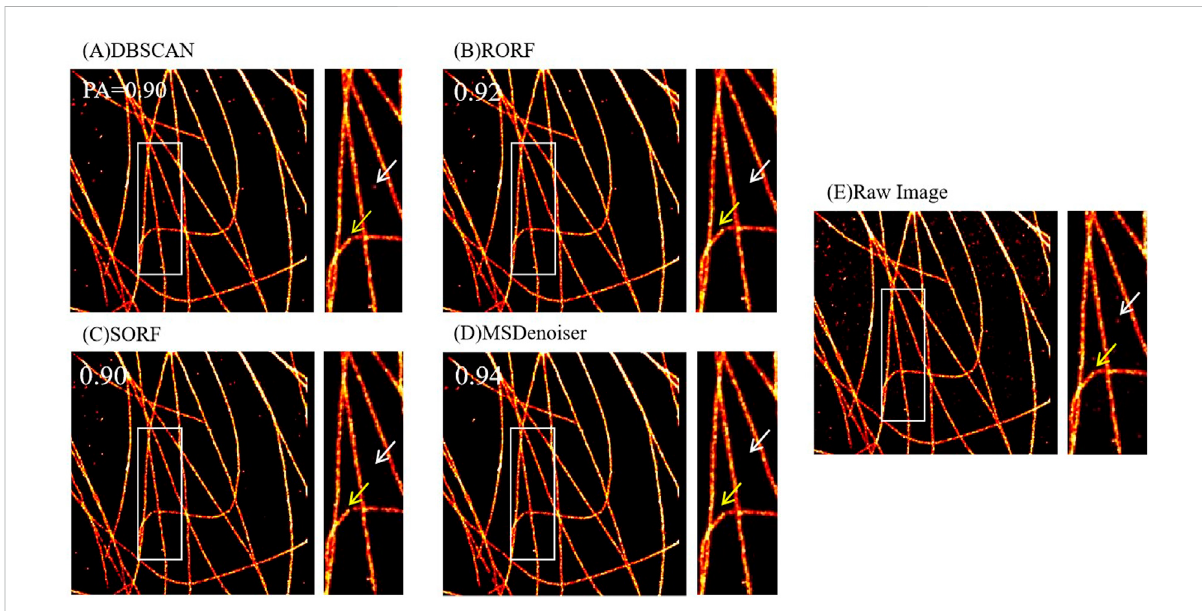
FIGURE 6 Comparison on the denoising performance of different methods using experimental microtubule data. (A) Denoised image from DBSCAN. (B) Denoised image from RORF. (C) Denoised image from SORF. (D) Denoised image from MSDenoiser. (E) Raw rendered image. The white arrows in (A – C) indicatenoise,andthewhitearrowin (D) indicatesthebetterdenoisingperformanceofMSDenoiseratthesamelocation.Theyellowarrowsin (A – C) indicate broken microtubule structure, and the yellow arrow in (D) indicates the structure continuity from MSDenoiser at the same location.